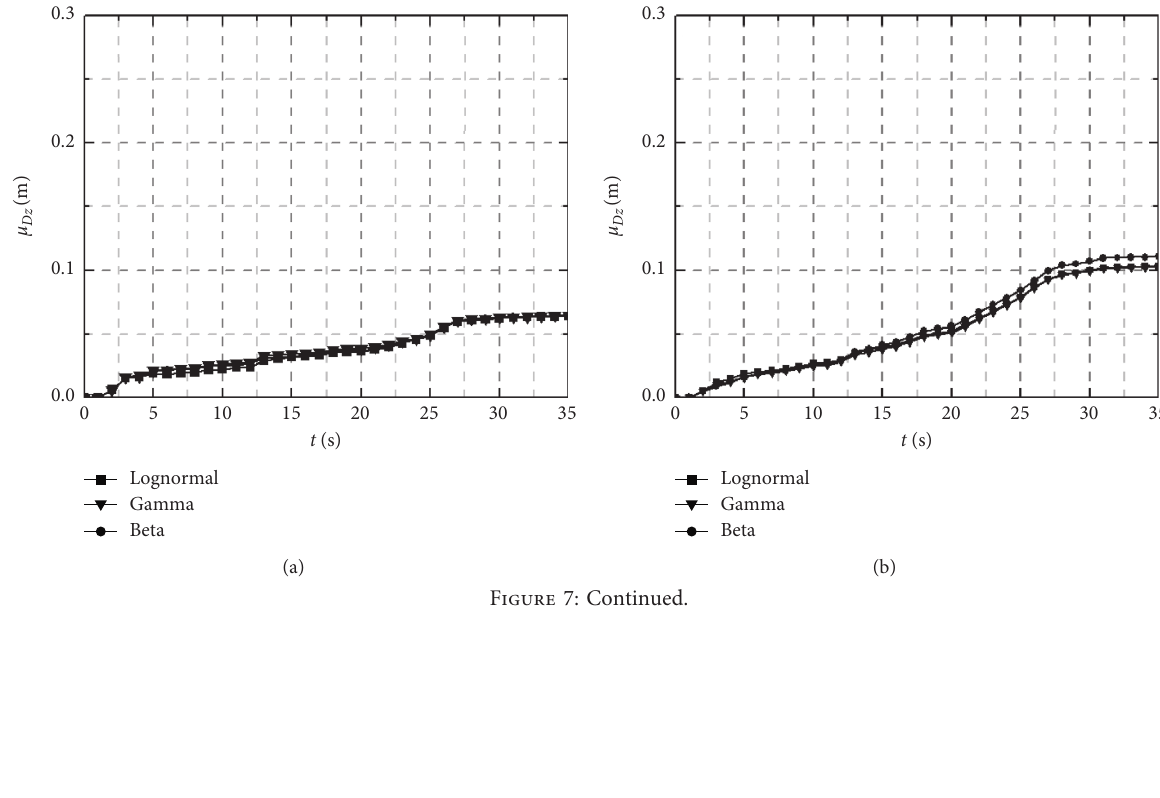
� 6m and (b) δ � 60m. x